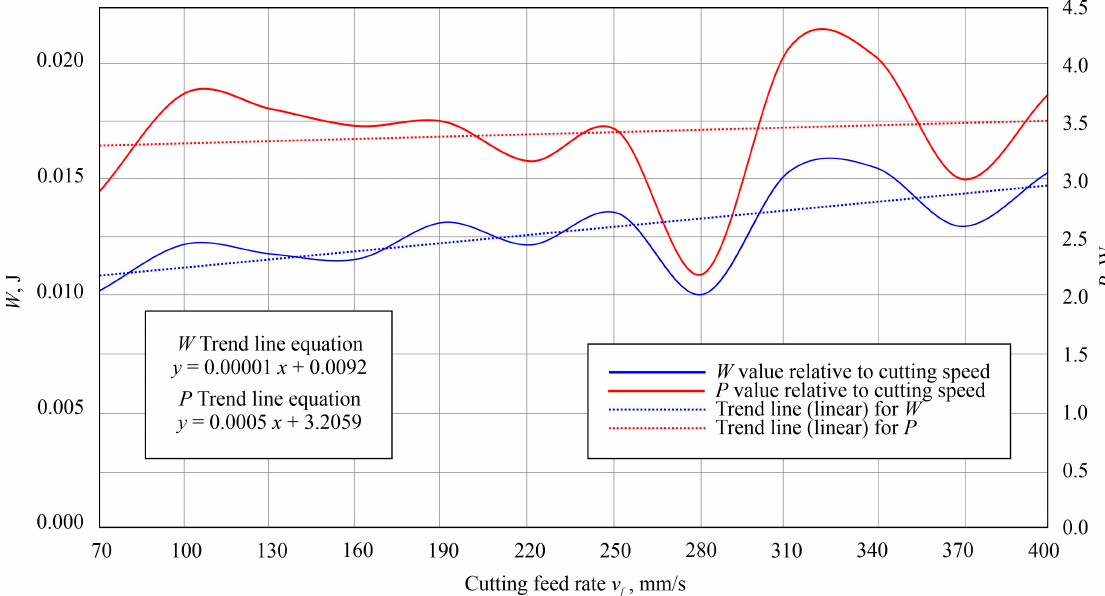
Figure 7. Chart for work W and power P relative to v f cutting speed.